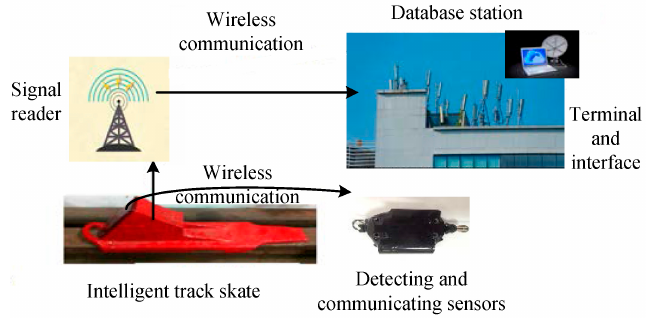
Figure 1. Composition and the work process of anti-runaway prevention system (ARPS).